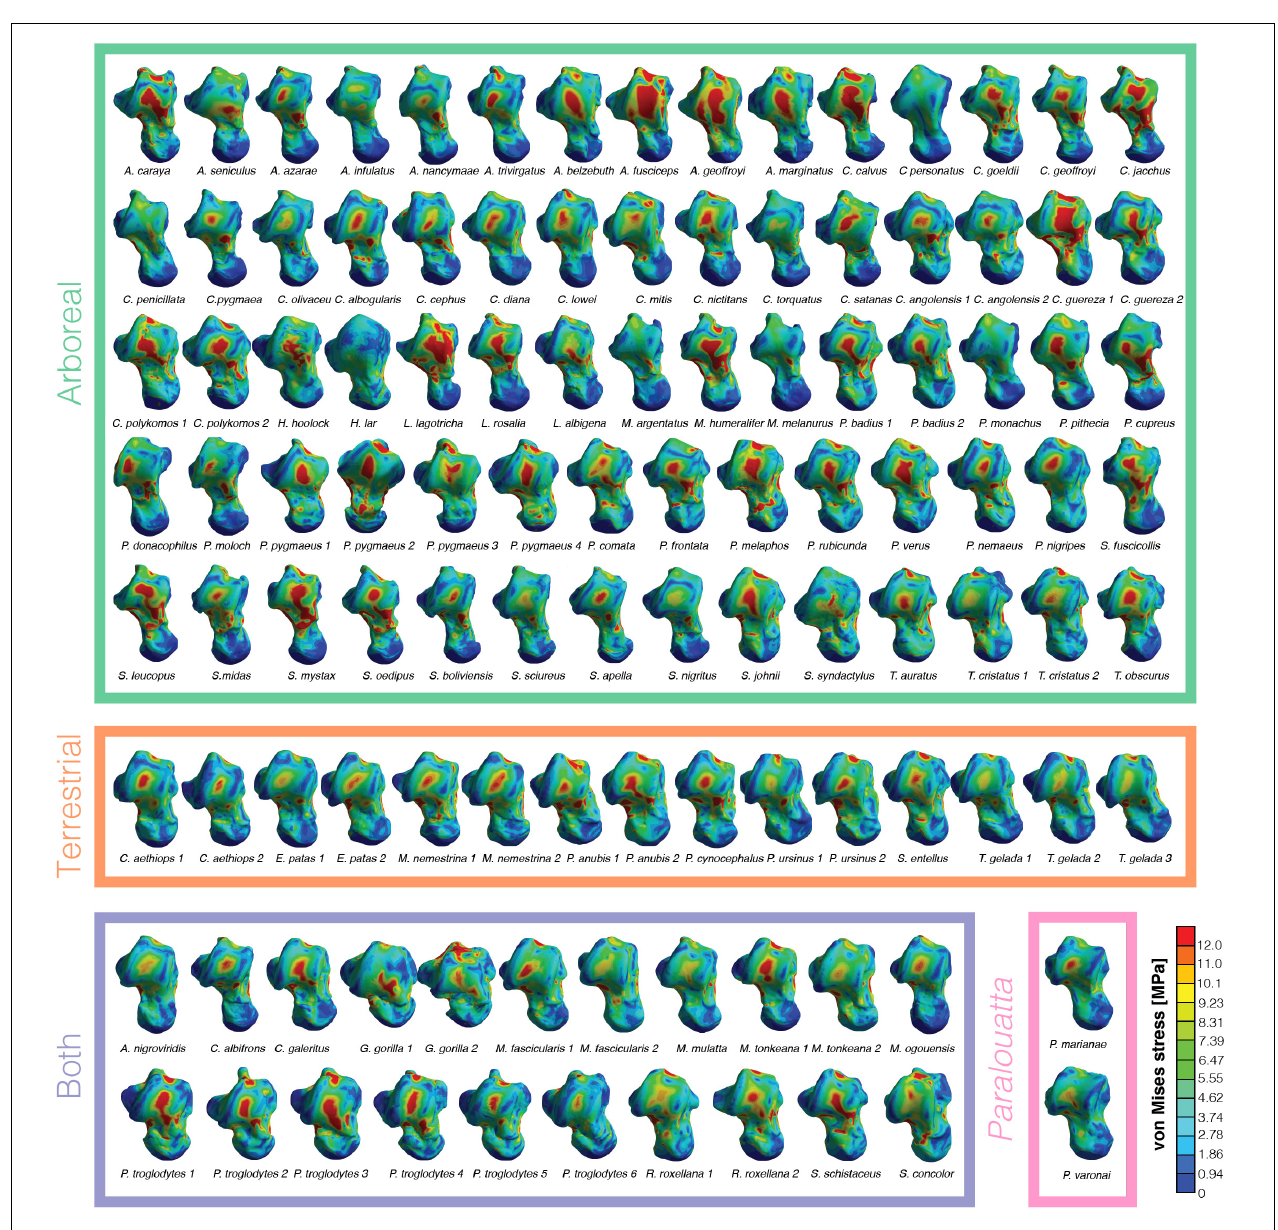
FIGURE 5 | von Mises stress distribution for all the analyzed